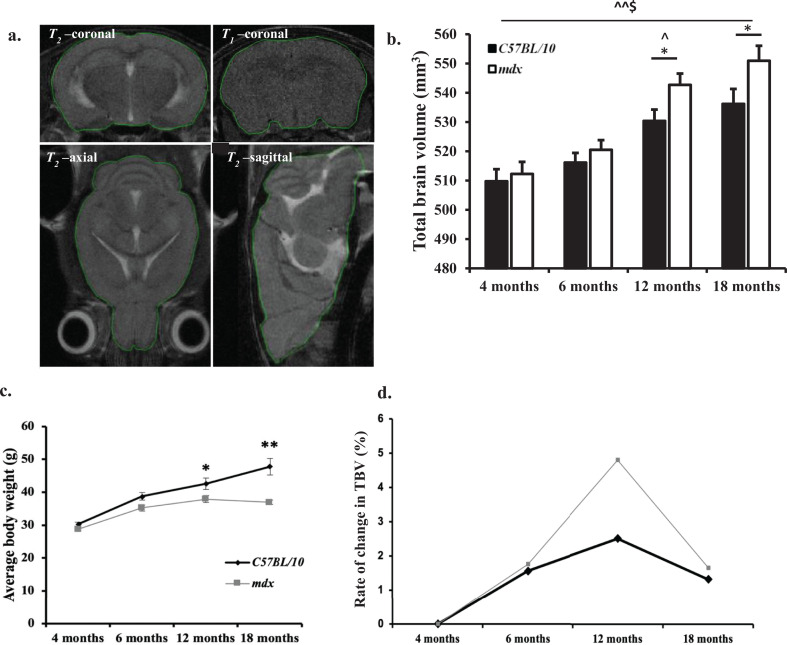
a–c: Longitudinal total brain volume (TBV) measurements. a. Representative images demonstrating the method used for estimation of total brain volume (TBV) in all mice using the polygon tool in ImageJ. The outline of each brain structure from representative T1-w coronal and T2-w -coronal, -axial and -sagittal images are delineated in green. b. Bar graph displaying longitudinal comparison of TBV. MRI derived TBV for mice at 4 months old, 6 months old, 12 months old and 18 months old (n = 8 mice per genotype at each time point). The control mouse brain increased in volume between 4 and 18 months old (p < 0.05). The mdx mice had a larger TBV compared to control mice from 12 months onwards (p < 0.01). Between 12 and 18 months old the mdx mice had a significantly larger TBV compared to control mice (p < 0.05). c. Line graph showing average body weights of mice used for the longitudinal MR imaging study. At 4 months old all mice have a comparable body weight. Between 12 and 18 months mdx mice begin to lose weight whereas control mice gain weight. Data presented as mean ± SEM, *p < 0.05, **p < 0.01 for control vs. mdx, ^p < 0.05, ^^p < 0.01 for changes observed with ageing in mdx mice, $<p.0.05 for changes observed with ageing in control mice. d. Line graph displaying the rate of change in TBV between 4 and 18 months old in control C57BL/10 and mdx mice.